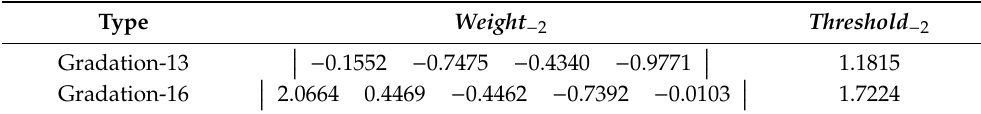
Table 13. The parameters from the hidden layer to output layer for Gradation-13 and Gradation-16.